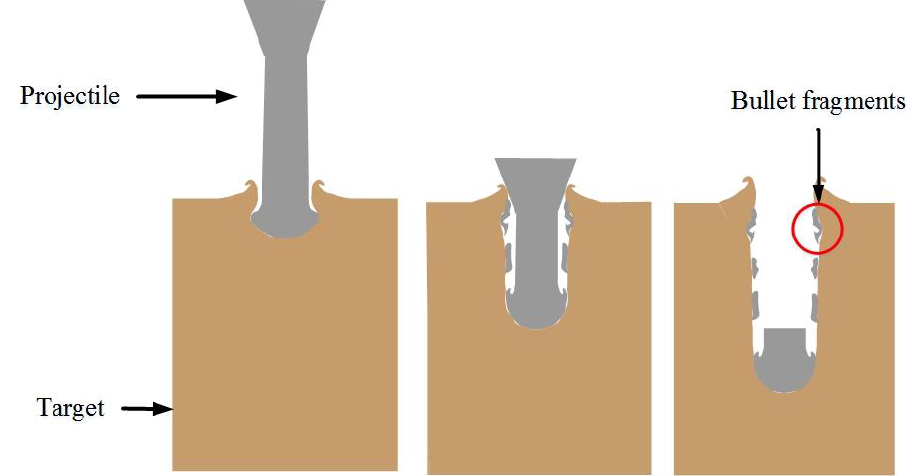
Figure 11. Penetration progress of RHA plates by the tungsten alloy projectile.